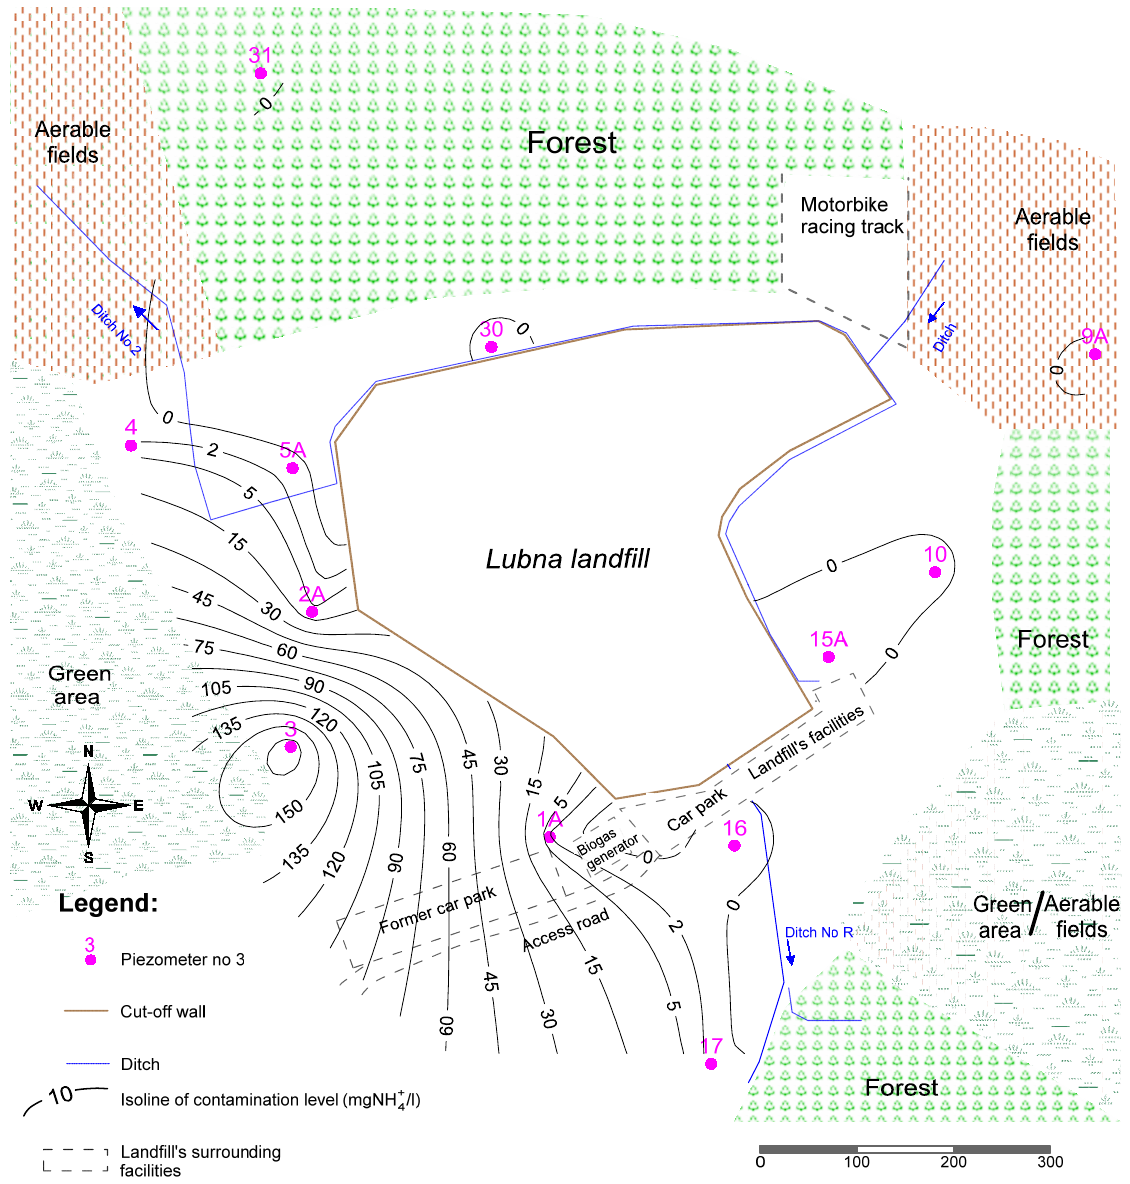
Figure 9. Distribution map of ammonium contamination within Lubna Landfill surroundings (2003), five years after vertical barrier